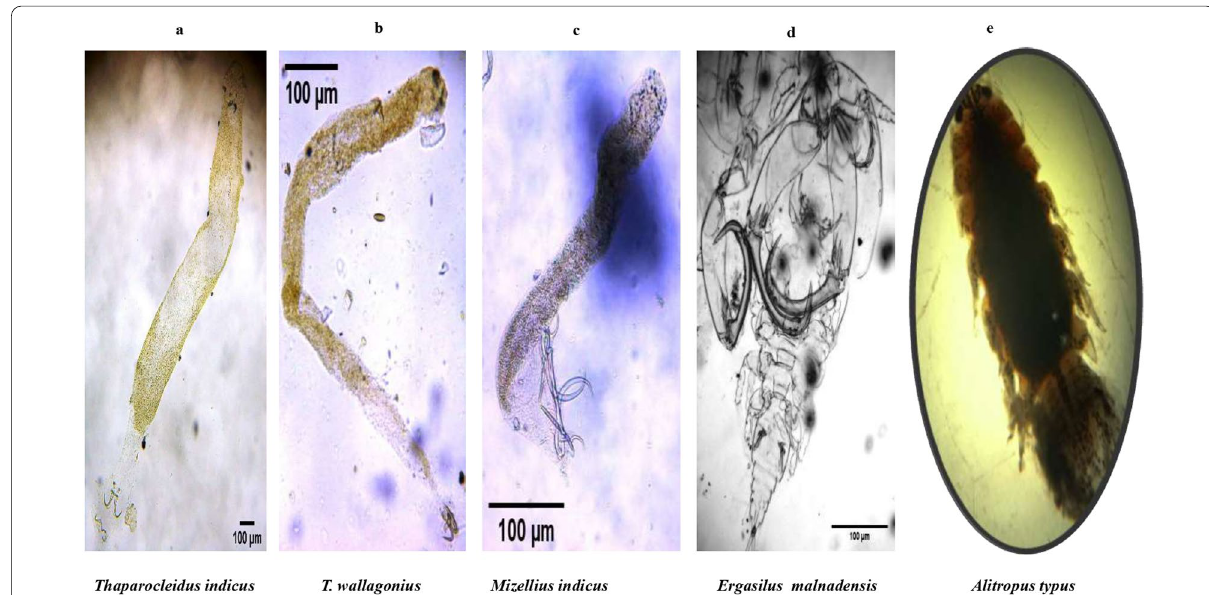
Fig. 3 a – e Microphotographs of ectoparasites of W. attu , a Thaparocleidus indicus ; b Thaparocleidus wallagonius ; c Mizelleus indicus , d Ergasilus malnadensis, e Alitropus typus